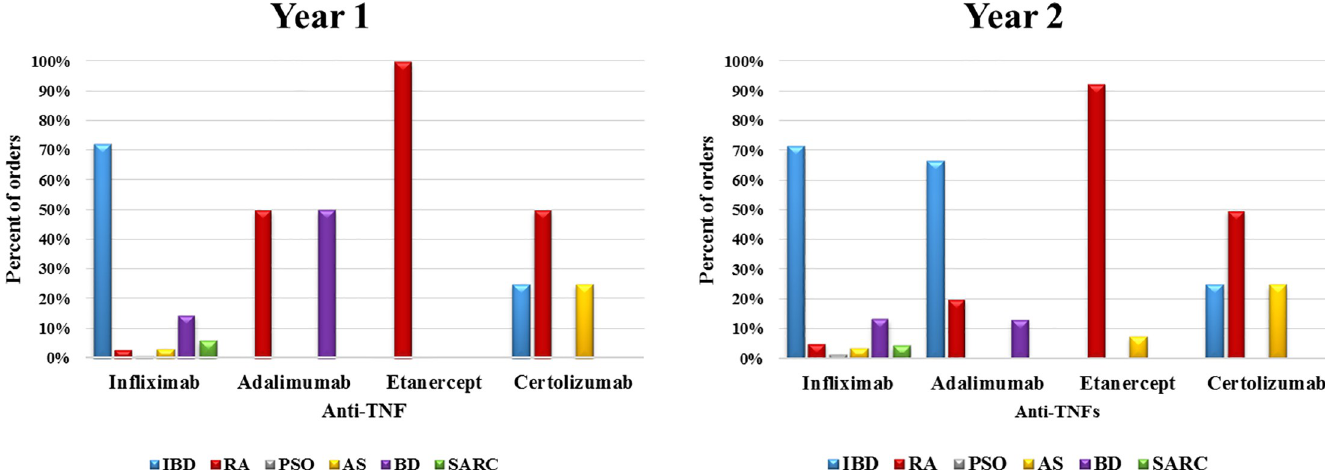
Fig 1. DUR of Anti-TNFs by indication during first and second years at KSUMC. IBD: inflammatory bowel disease; RA: rheumatoid arthritis; PSO: psoriasis; AS: ankylosing spondylitis; BD: Behcet’s disease; SARC: Sarcoidosis.